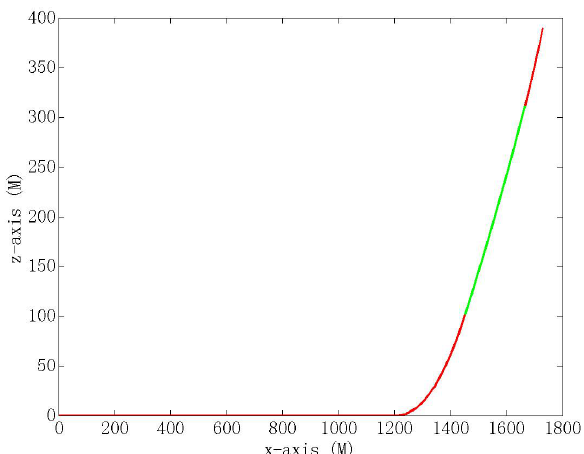
Figure 9. Configuration of the multicomponent mooring